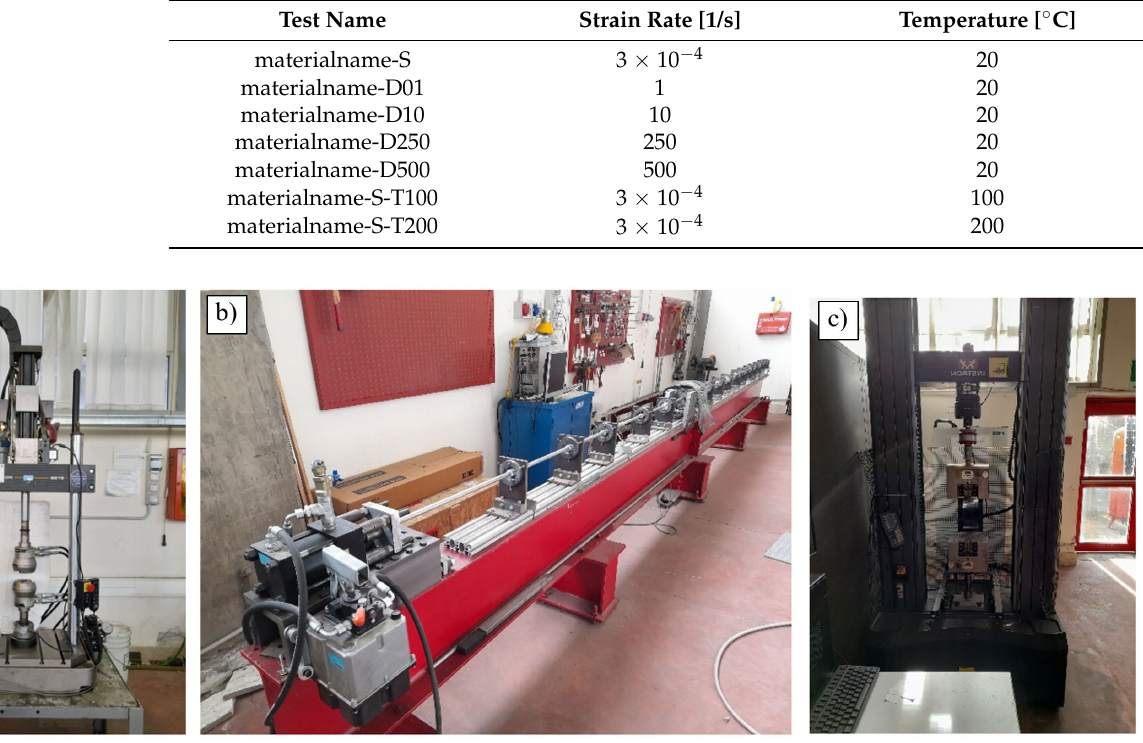
Figure 2. Testing equipment for experiments: ( a ) Hydraulic machine for slower dynamic tests, ( b ) SHTB for faster dynamic tests, and ( c ) motor-driven machine with climatic chamber for static tests at different temperatures.